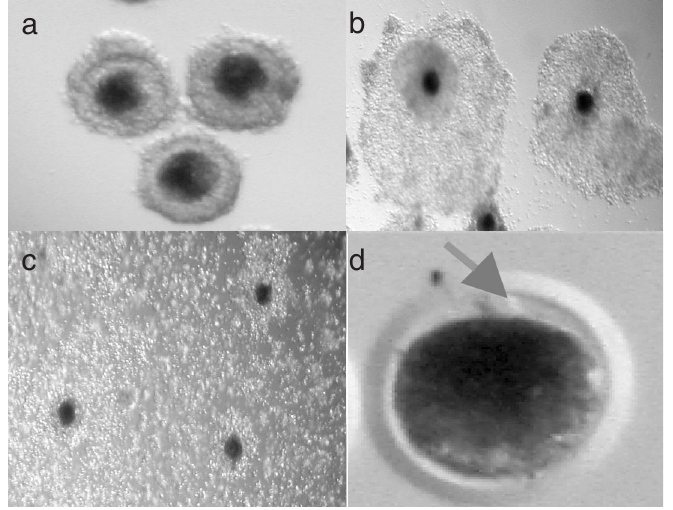
Figure 1. Pig cumulus cell expansion and nuclear maturation in San Marcos (SM) culture medium. a , Immature cumulus-oocyte complex in SM (30X); b , cumulus expansion at 24 h at 37 o C in SM (30X); c , cumulus expansion at 44 h at 37 o C in SM + porcine follicular fluid + gonadotropins (30X); d , mature oocyte with a polar corpuscle in SM (100X).